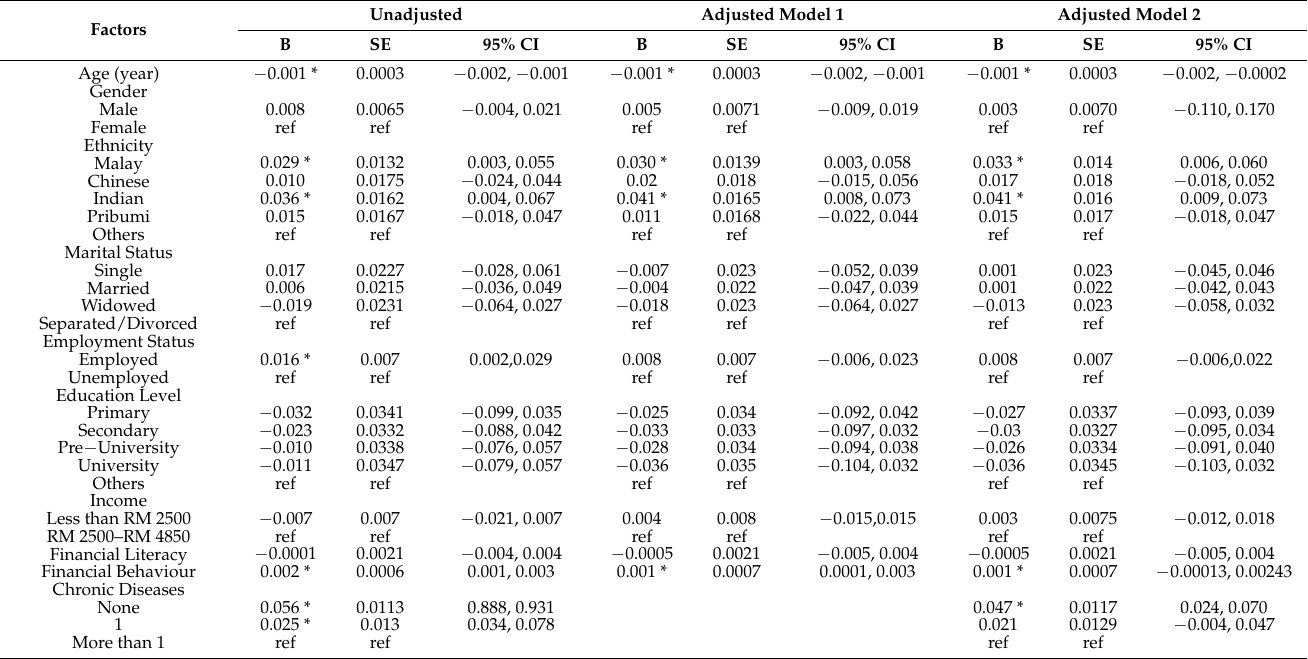
Table 3. Multivariate analysis on the determinants of